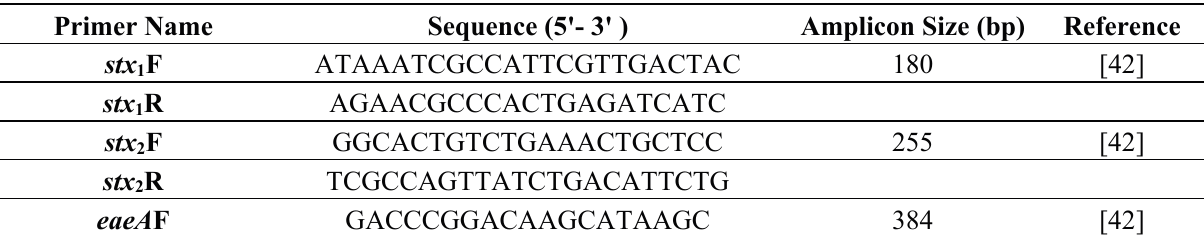
Table 3. Primers used for pathogenic E. coli